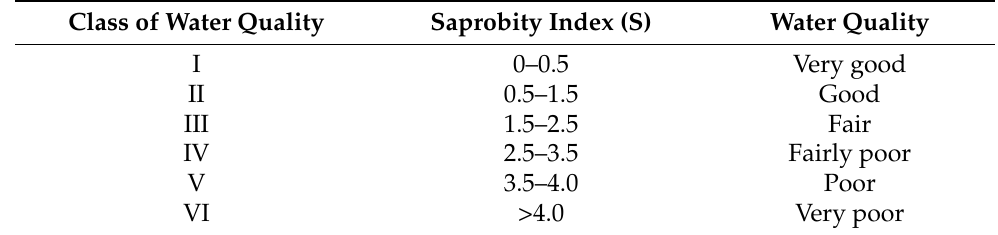
Table 1. Determination of water quality (EU color codes) based on saprobity index (S) according to [31].